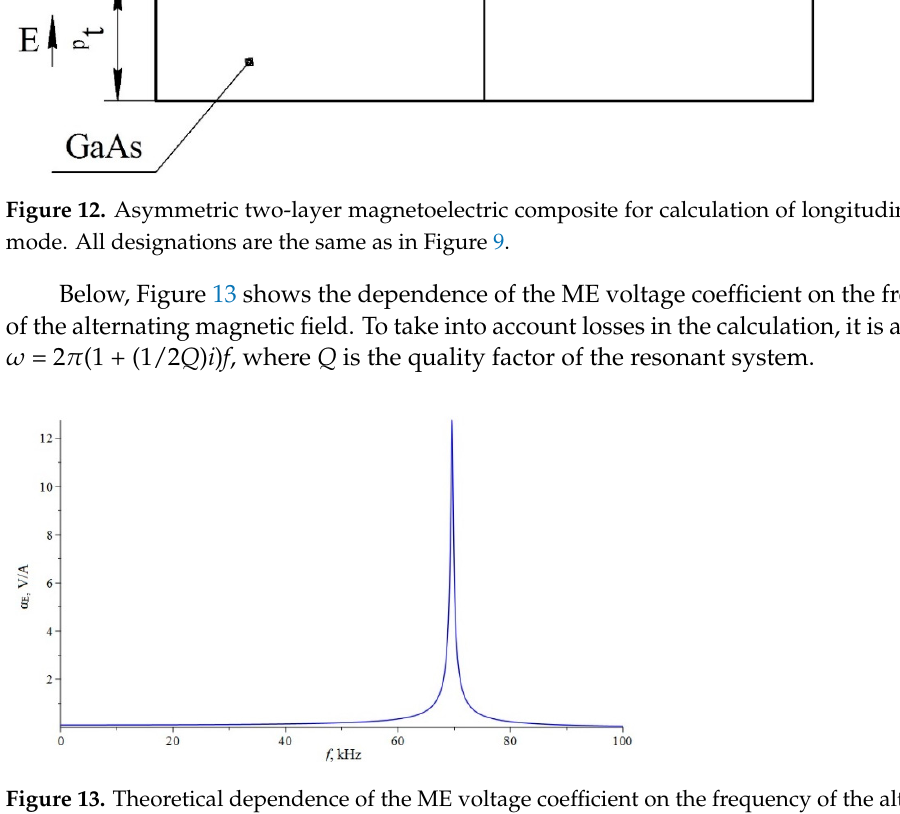
Figure 13. Theoretical dependence of the ME voltage coefficient on the frequency of the alternating magnetic field for asymmetrical ME structure Metglas/GaAs of the longitudinal-shear mode.